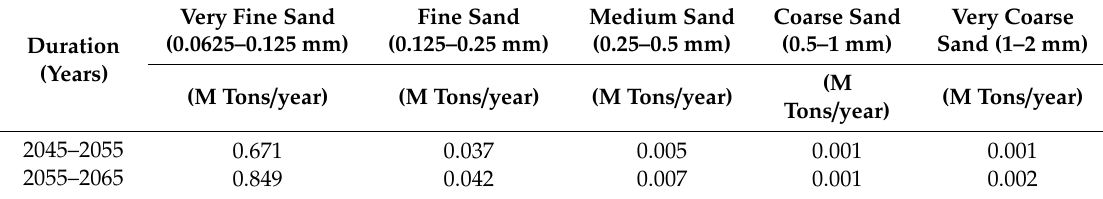
Table 8. Outflows of di ff erent sand fractions from the reservoir for